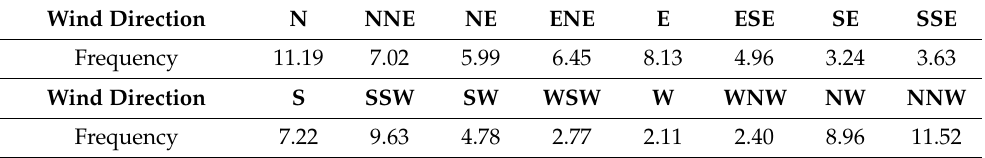
Table 4. Annual frequency of wind directions in Hangzhou